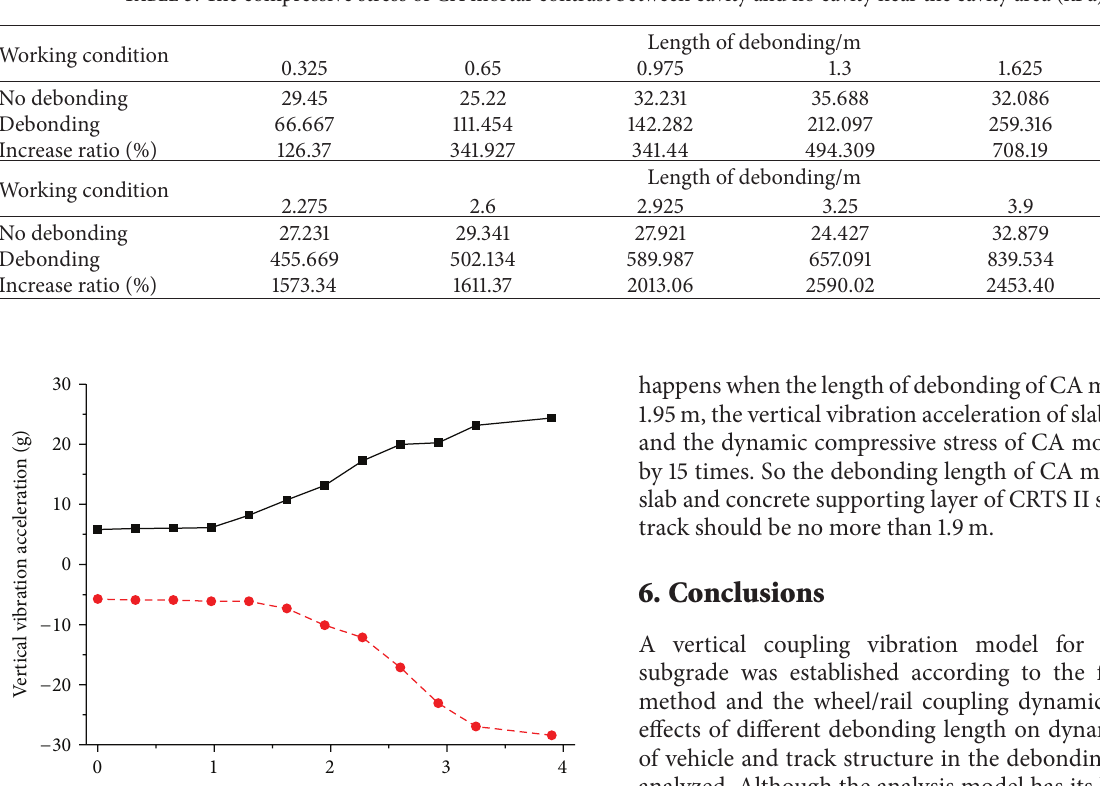
Table 3: The compressive stress of CA mortar contrast between cavity and no cavity near the cavity area (kPa).